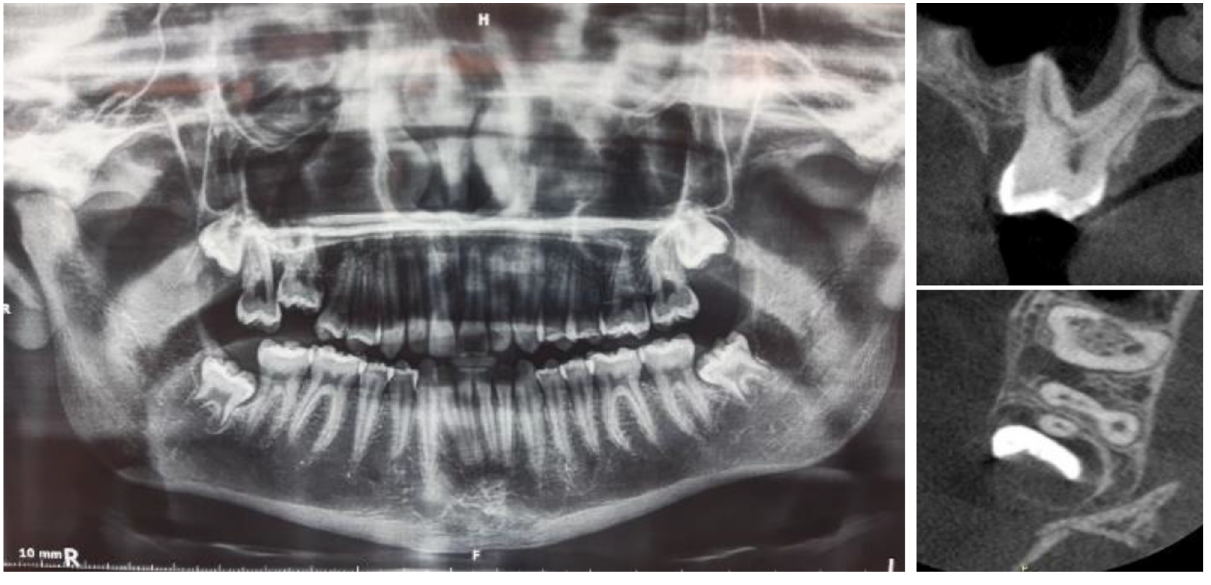
Fig. 1. Orthopantomogram and CBCT showing tooth 16 stuck in upper position with mesial bone replacement resorption.